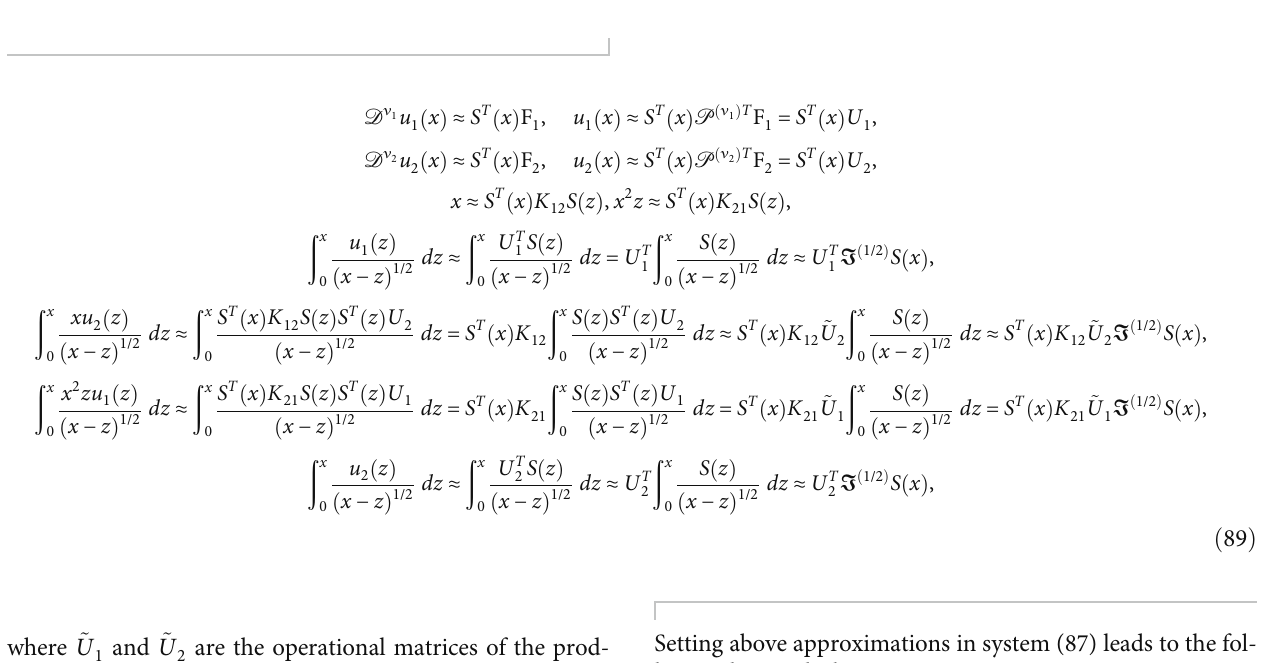
Figure 1: The graphs of the exact and approximate solutions and the absolute error function of ~ u